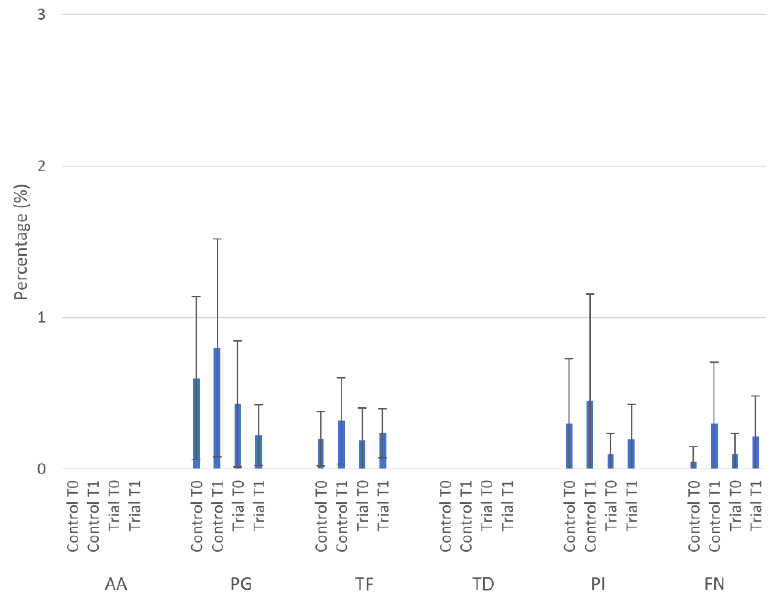
Figure 3. Percentage of the bacteria tested in the study (this figure shows the data reported in Table 5). Neither Aggregatibacter actinomycetemcomitans nor Treponema denticola were detected